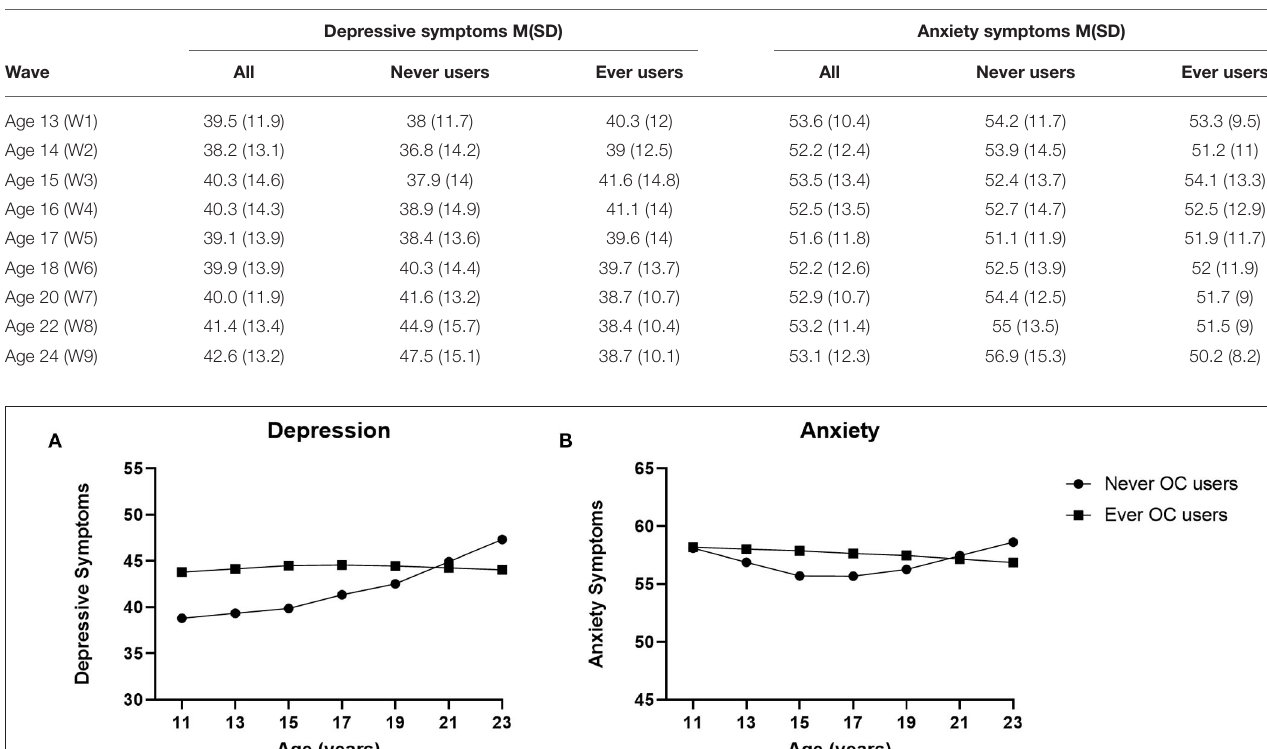
TABLE 2 | Depressive and anxiety symptoms per study wave. Depressive symptoms M(SD) Anxiety symptoms M(SD) All